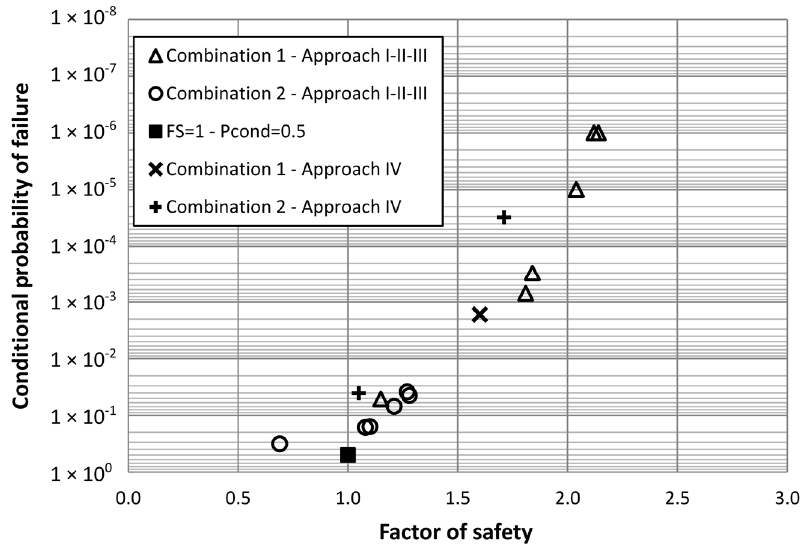
Figure 5. Factor of safety vs. Conditional probability of failure using 5% fractile for strength characteristic values, and including 5% fractile of factor of safety distribution for Approach IV.